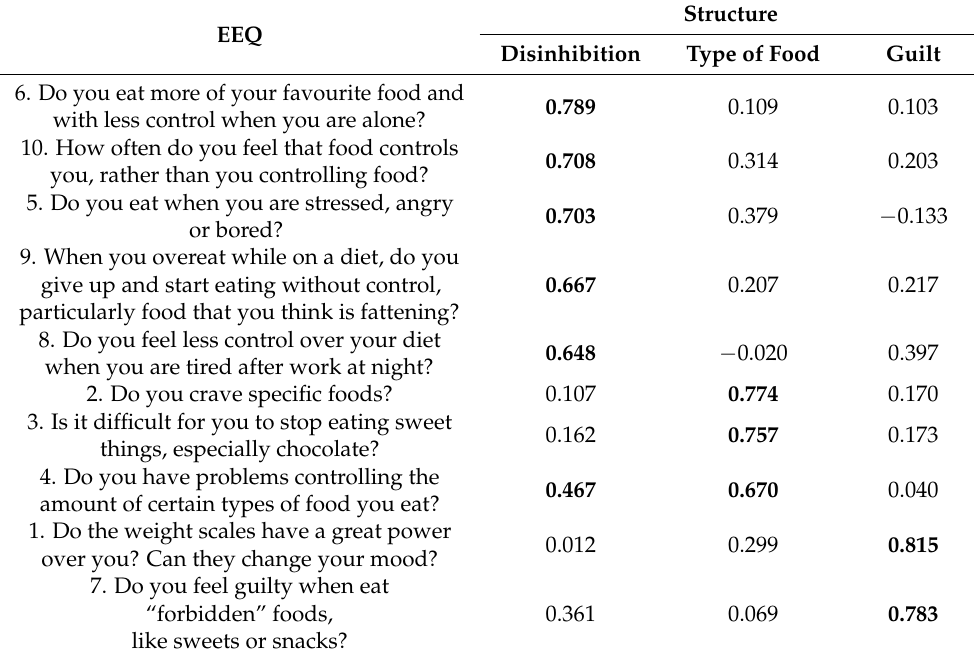
Table 2. Factor loadings After Varimax Rotation with Kaiser Normalization. EEQ